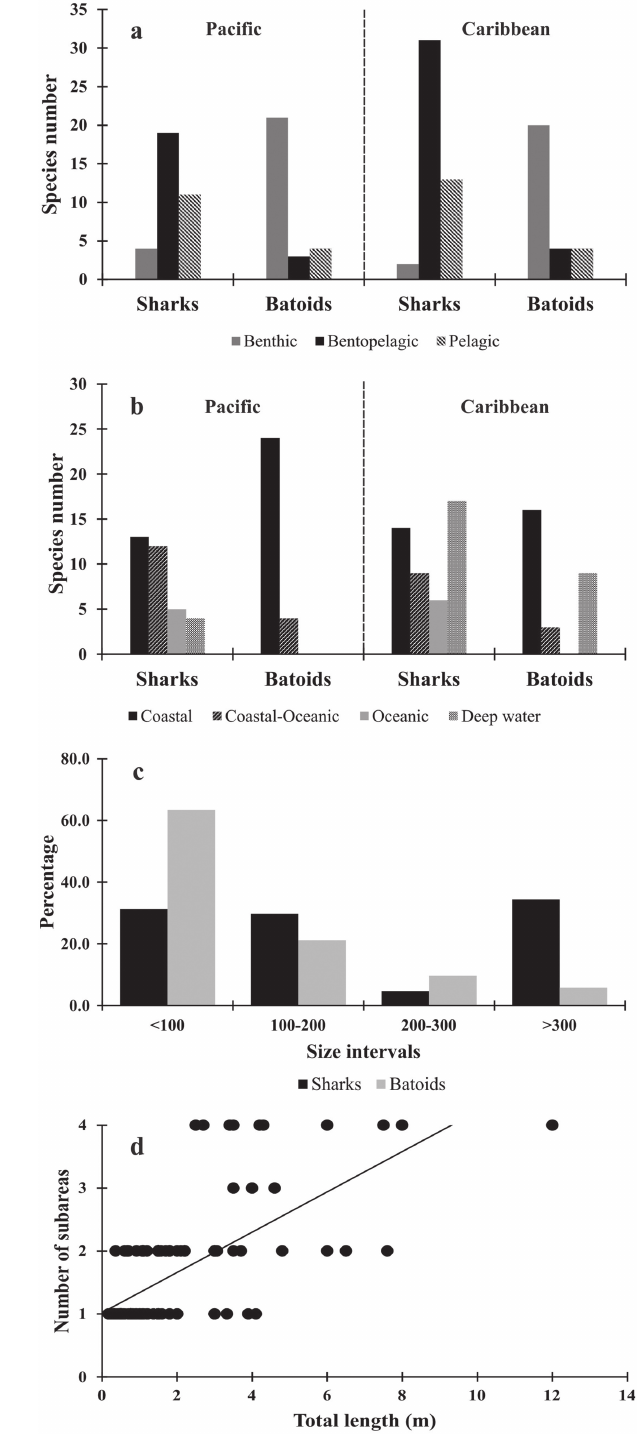
Fig. 4. Shark and batoid richness per habitat (a) and per habit (b) in the Colombian Pacific and Caribbean waters, and relationship between the body size of Colombian marine elasmobranchs and its richness (c; values expressed in percentage) and the number of sub-areas (Oceanic Caribbean, Coastal Caribbean, Oceanic Pacific, and Coastal Pacific) occupied by them